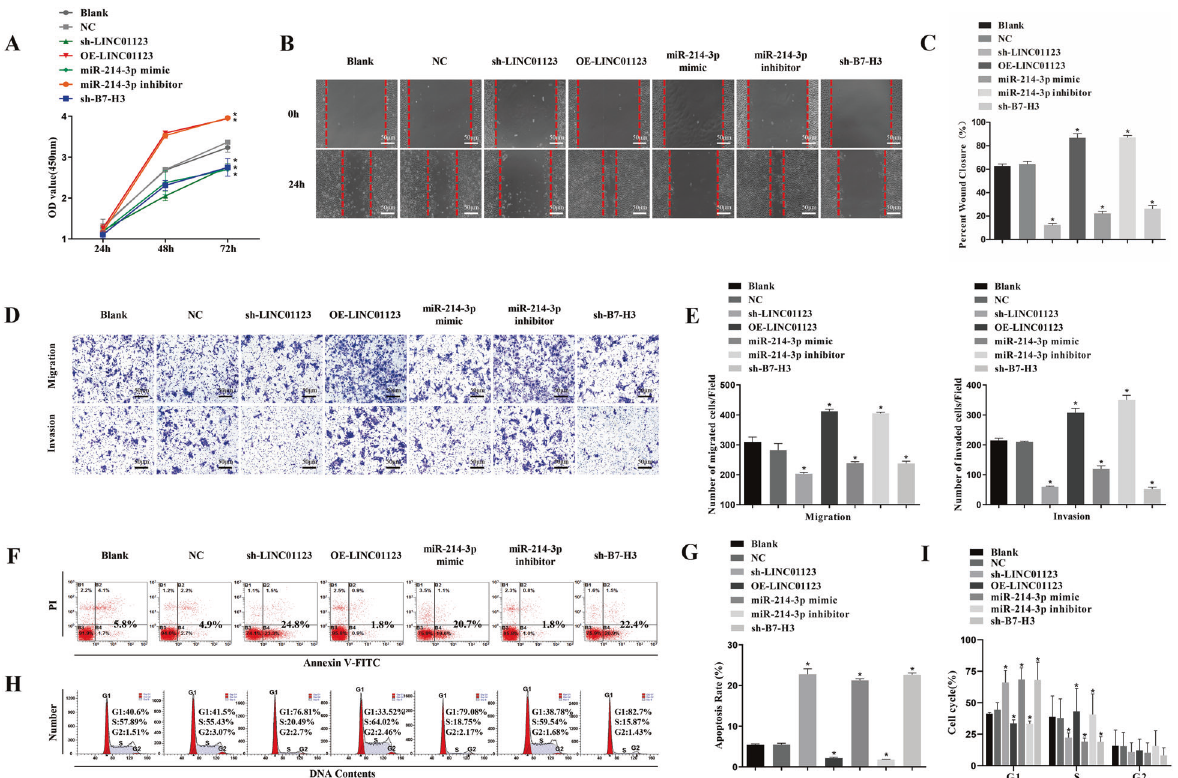
Fig. 3 Downregulation of LINC01123 or B7 – H3 or upregulation of miR-214-3p inhibited HNSCC cell proliferation, migration, and invasion in vitro. HNSCC cells (CAL-27) were treated with sh-LINC01123, OE-LINC01123, miR-214-3p mimic, miR-214-3p inhibitor, or sh- B7 – H3 . A Cell Counting Kit 8 (CCK8) assay of the proliferation of HNSCC cells. B Motility of HNSCC cells was determined by scratch wound healing assay. C Statistical results of scratch wound healing assay. D Migration and invasion of HNSCC cells were determined by transwell migration and invasion assay. E Statistical analysis of transwell results. F Apoptosis rate of HNSCC cells, as detected by fl ow cytometry. G Statistical results of the apoptosis rate. H Cell cycle stages of HNSCC cells, as detected by fl ow cytometry. I Statistical analysis of the cell-cycle results. * P < 0.05 versus the blank group. The experiment was repeated three times.